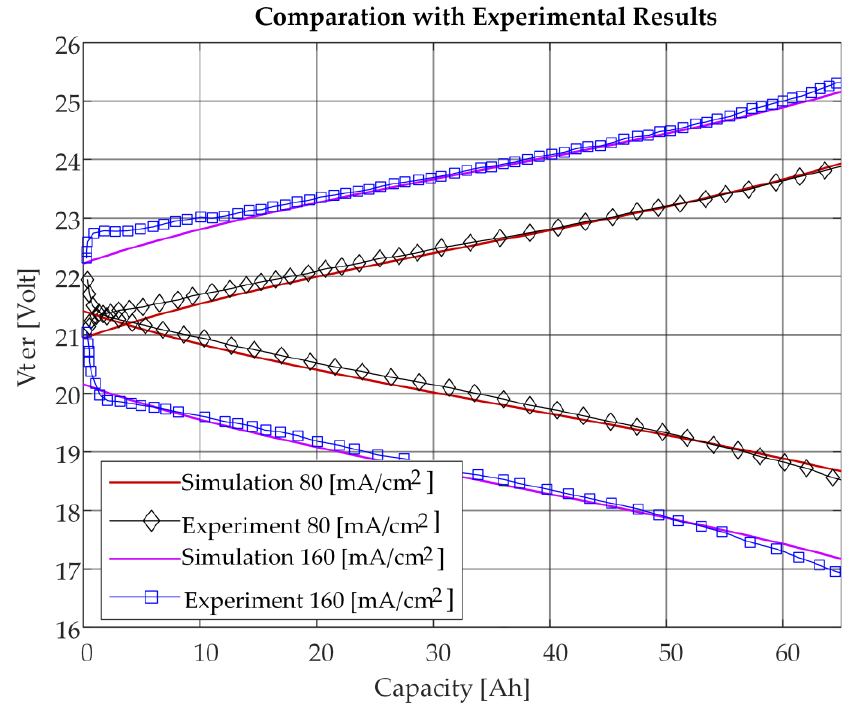
Figure 7. Model comparison with the experimental data.